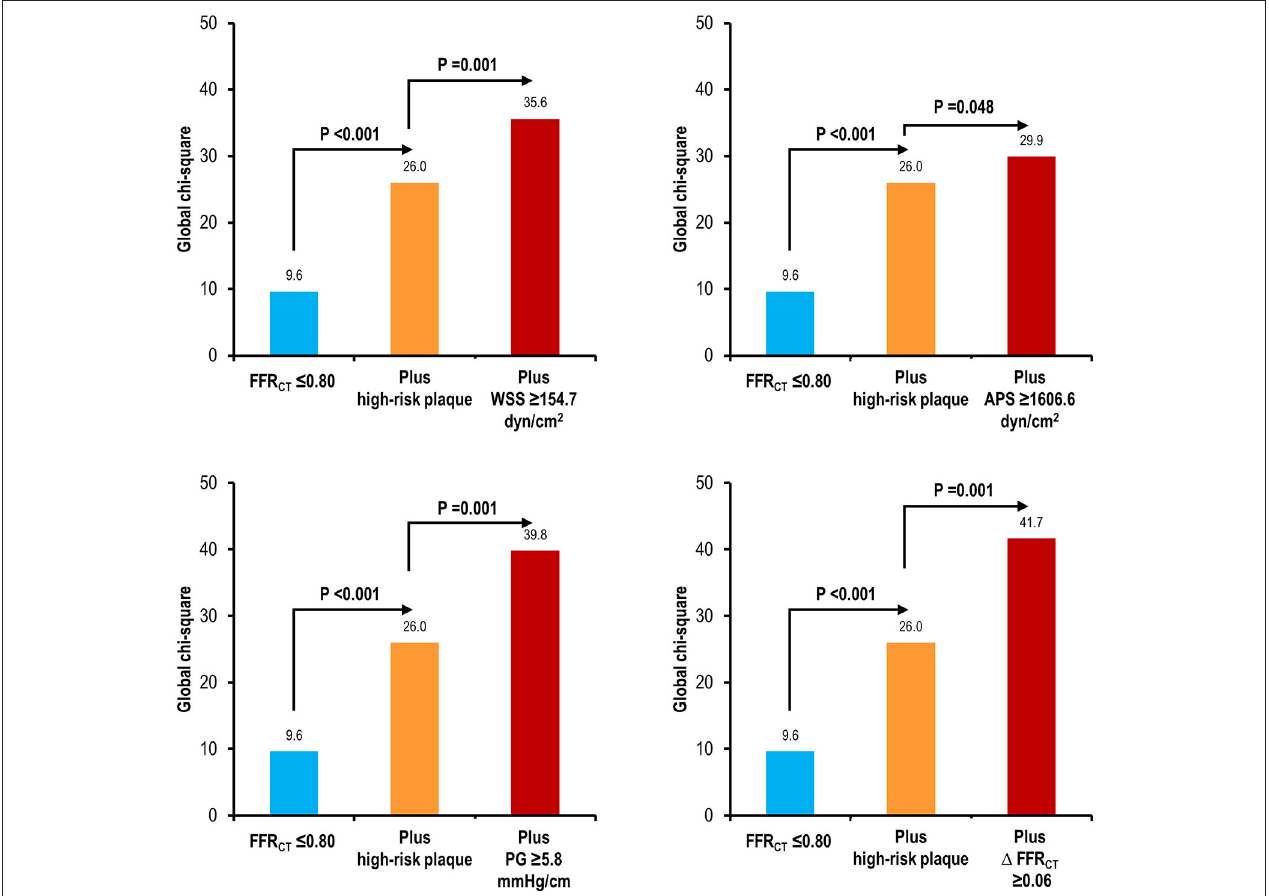
FIGURE 3 | Incremental predictive value of high WSS, high APS, high PG, or high 1 FFR CT over high-risk plaque and FFR CT . The predictability for culprit lesions causing ACS is compared with the model with FFR CT ≤ 0.80; the model with FFR CT ≤ 0.80 and high-risk plaque; and the model with FFR CT ≤ 0.80, high-risk plaque, and local hemodynamic parameters. High WSS, high APS, high PG, or high 1 FFR CT similarly improved the predictability for culprit lesions causing ACS of high-risk plaque and FFR CT ≤ 0.80. High-risk plaque was defined as a plaque with ≥ 2 of low-attenuation plaque, positive remodeling, spotty calcification, and napkin-ring sign. APS, axial plaque stress; FFR CT , coronary computed tomographic angiography-derived fractional flow reserve; PG, pressure gradient; WSS, wall shear